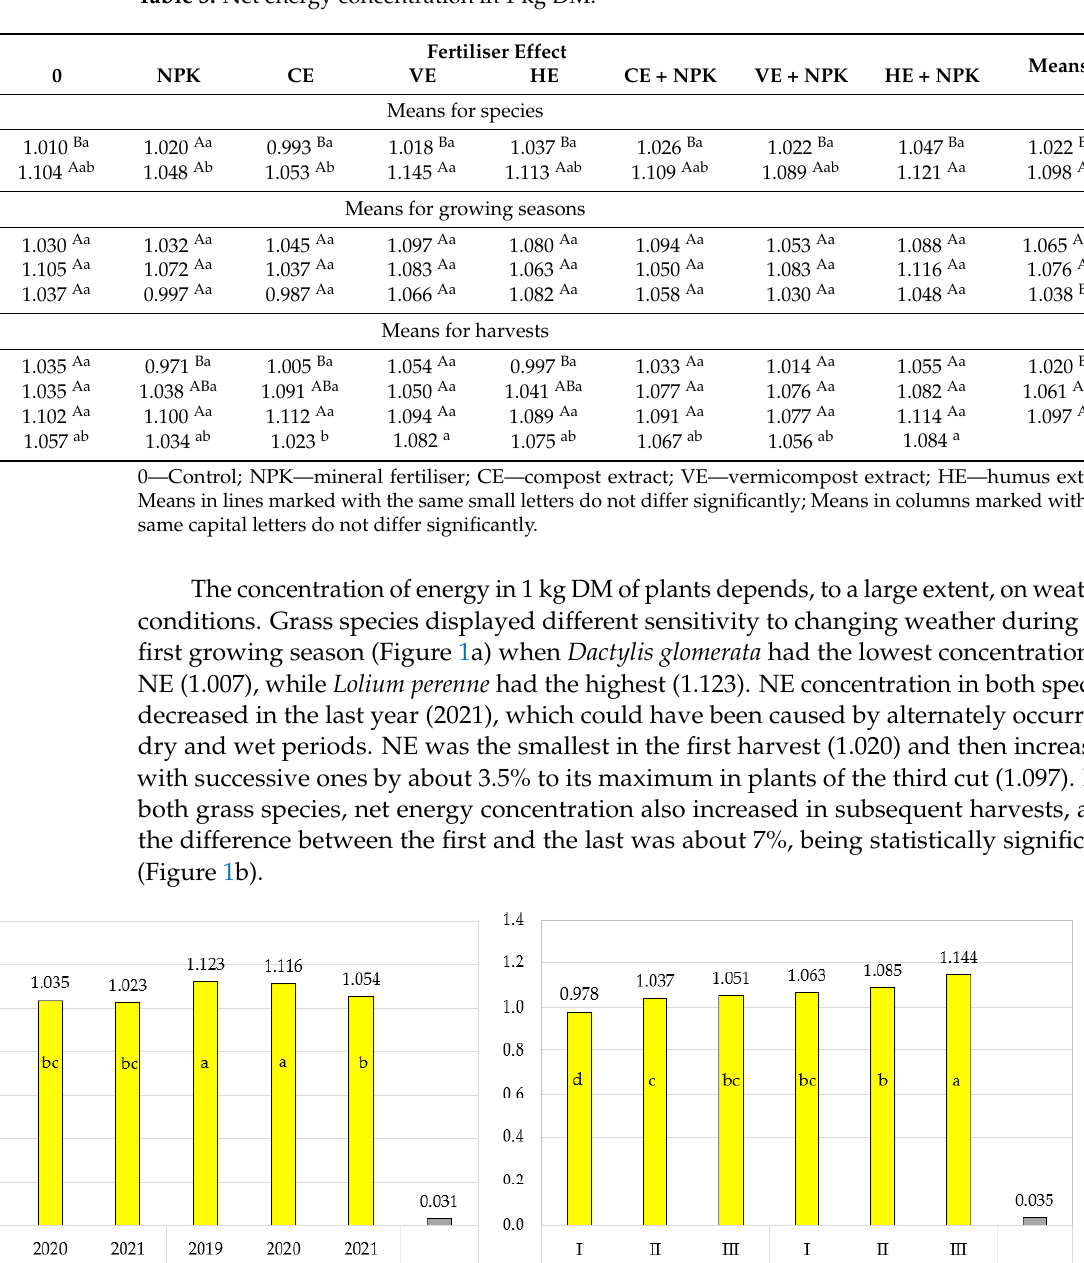
Table 3. Net energy concentration in 1 kg DM.